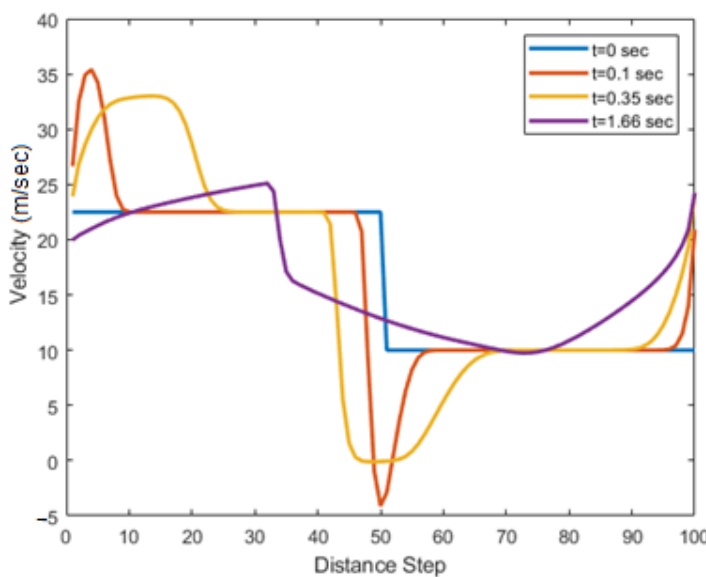
Figure 3. Velocity behavior of PW model on straight road with ingress traffic.